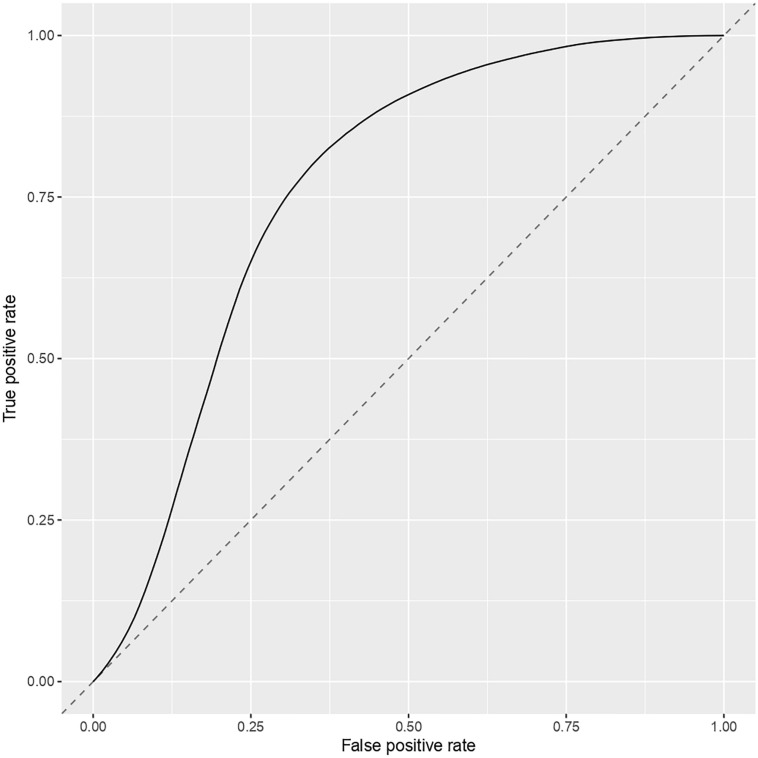
ROC curve for the three-gene model.